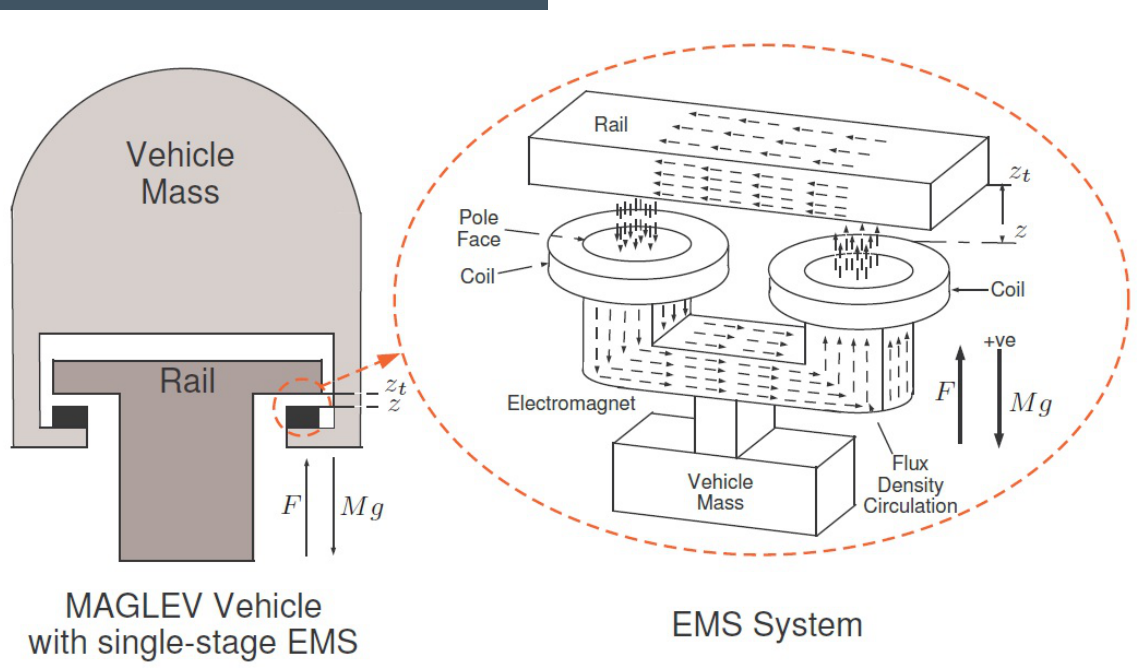
Figure 1. Diagram of a MAGLEV vehicle and the single-stage EMS system